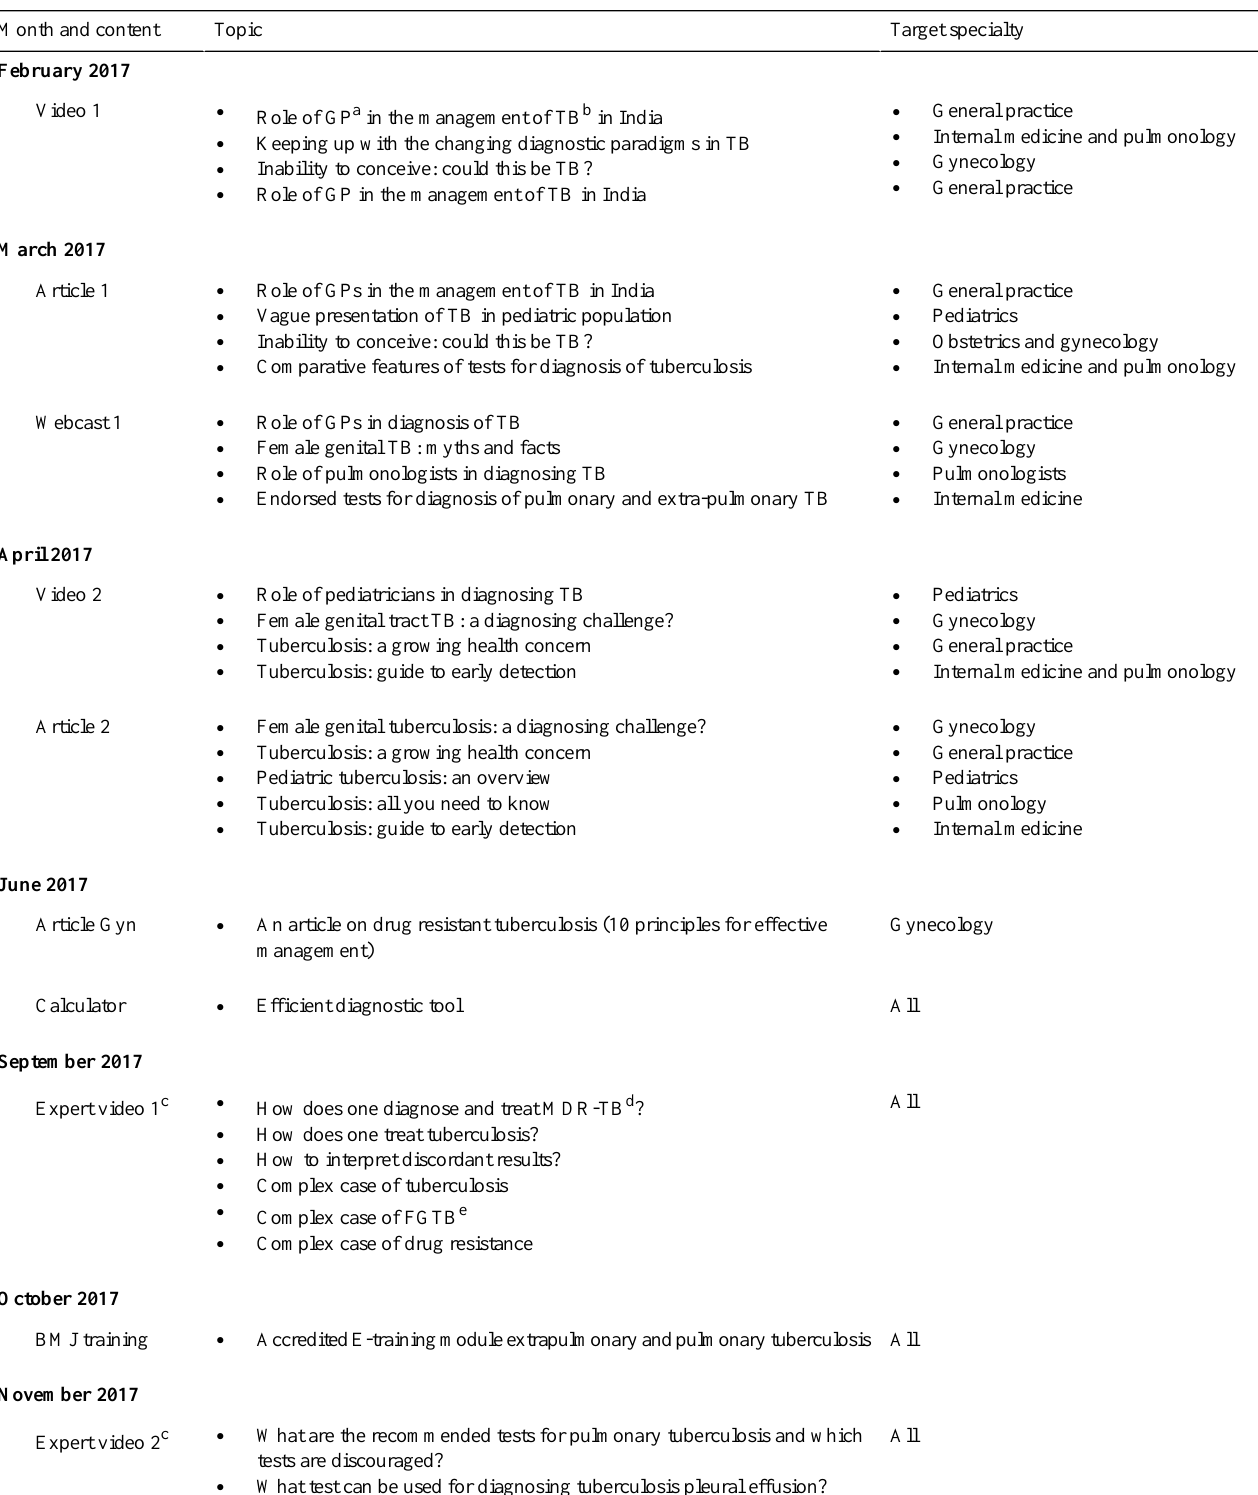
Table 1. Details of content pieces delivered in the ThinkTB